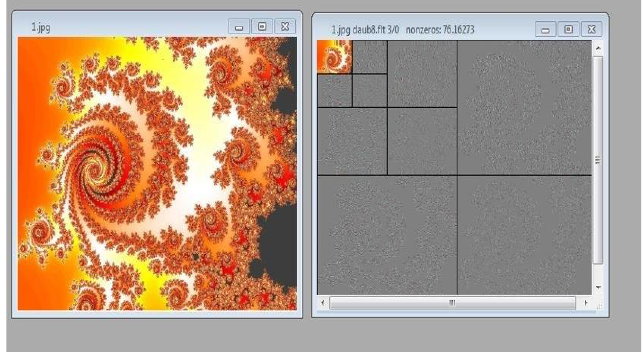
Figure 18 Using fractal results in applications for the compression or decompression of images. Figure 18. Using fractal results in applications for the compression or decompression of